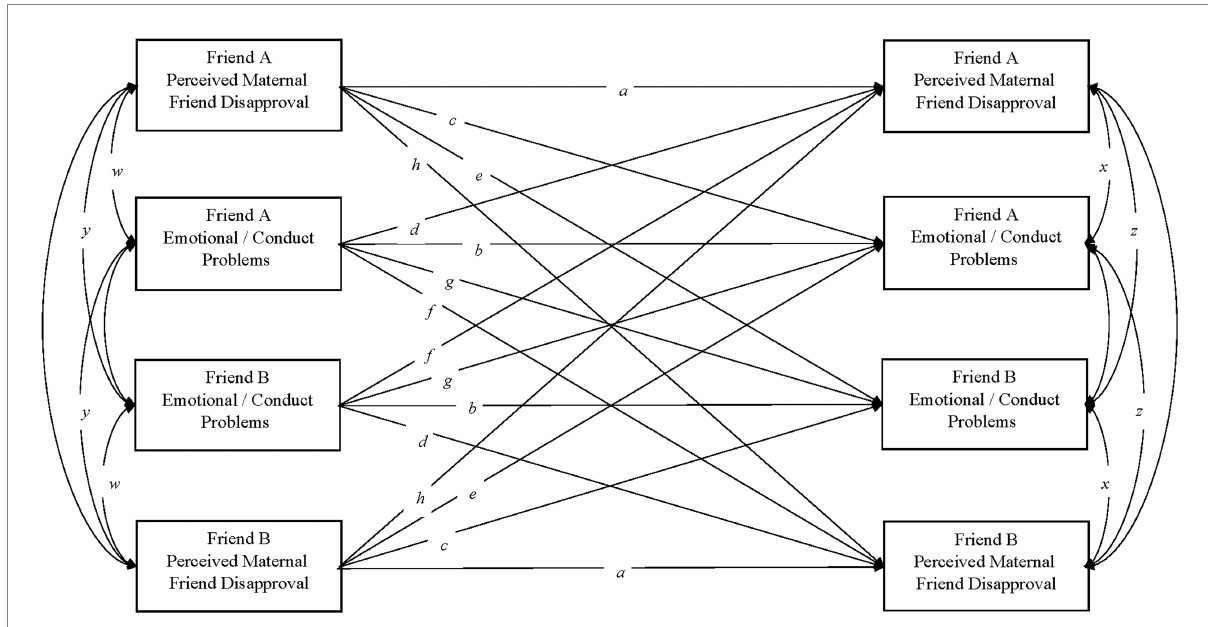
FIGURE 1 Measurement model of bivariate longitudinal indistinguishable dyad APIM. The model includes stability paths ( a and b ), within-person influence paths (c and d), between-person influence paths ( e , f , g , and h ), within-person correlations ( w and x ) between-person correlations ( y and z ). Identical label reflects equality constraints.